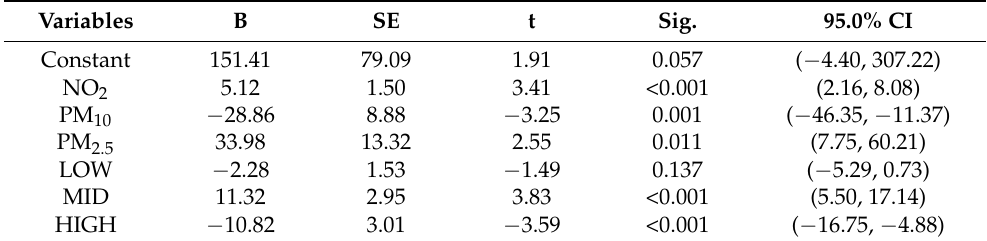
Table 2. The regression coefficients of joint noise level at low-, mid-, and high-frequency com- ponents and air concentrations of NO 2 , PM 10 , and PM 2.5 ( µ g/m 3 ) showing impact on registered hypertension